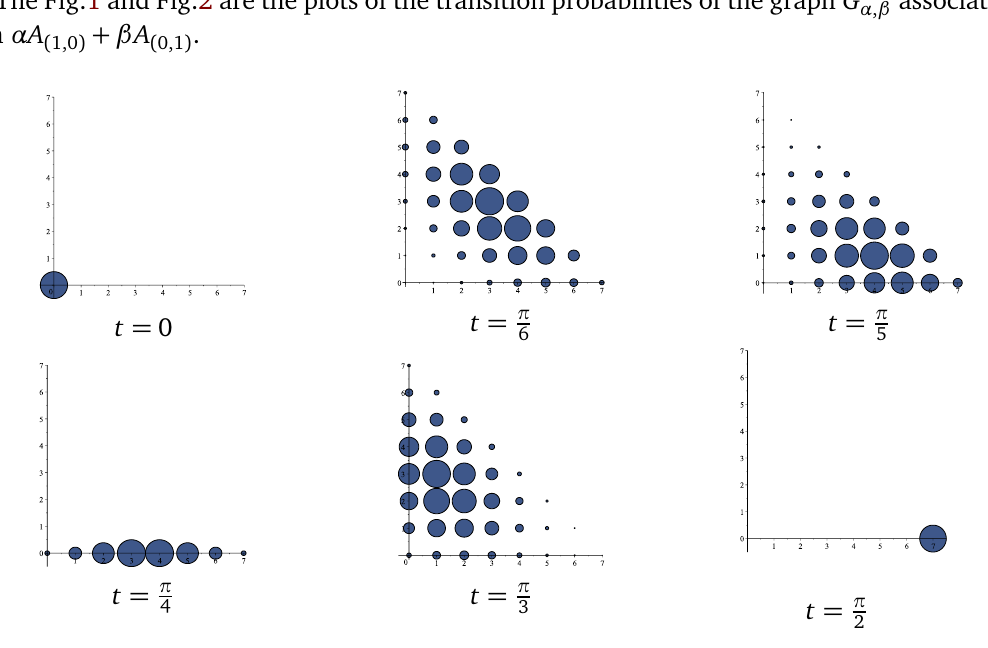
Figure 1: The transition amplitude | f of the circles are proportional to | f ( π at and FR on the set of sites i = 0,1, ··· , N and j = 0 occurs at t = 2